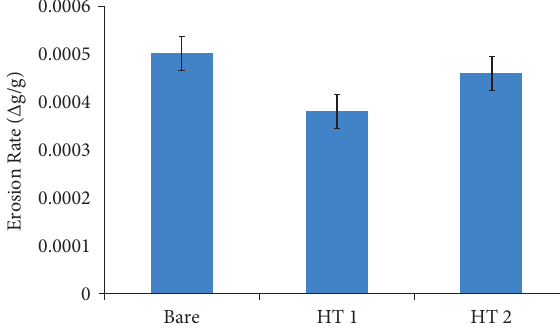
Figure 5: Erosion rate of the DMLS samples and hard particle impingement 90 ° .